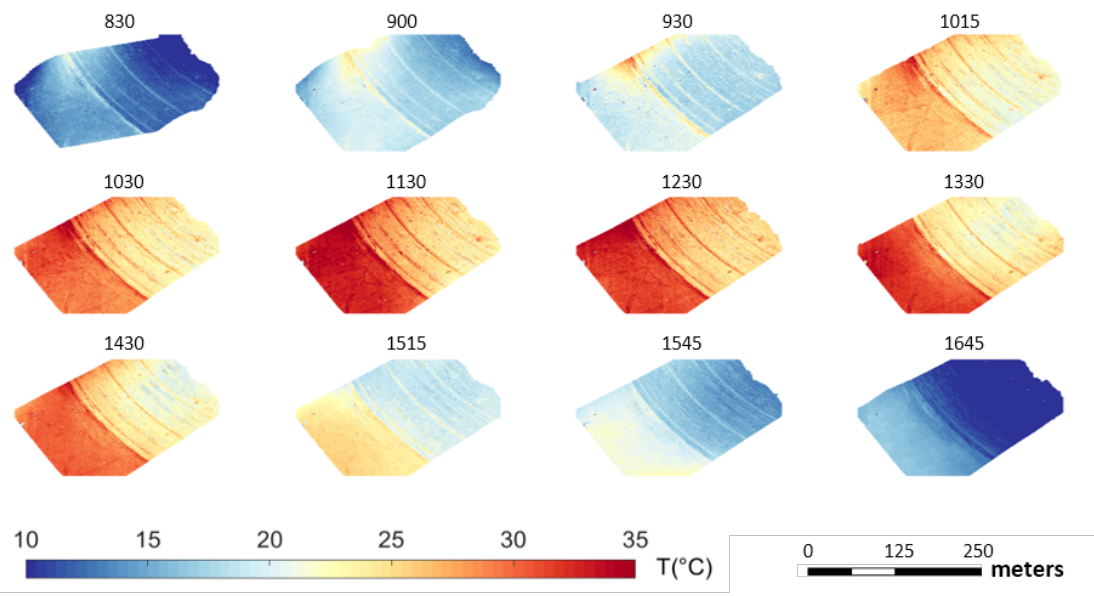
Figure 6. Maps of the UAV-based LST between 0830 and 1645 on 13 December